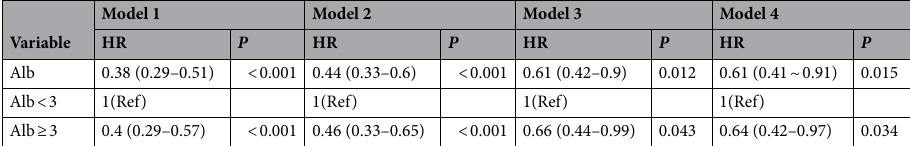
Table 2. Association between serum albumin and mortality in different models. Model 1 is not adjusted. Model 2 adjusts for age and sex. Model 3 adjusts for model 2 plus PEG, CHF, TC, dement, asp, and CRP. Model 4 adjusts for model 3 plus CI,